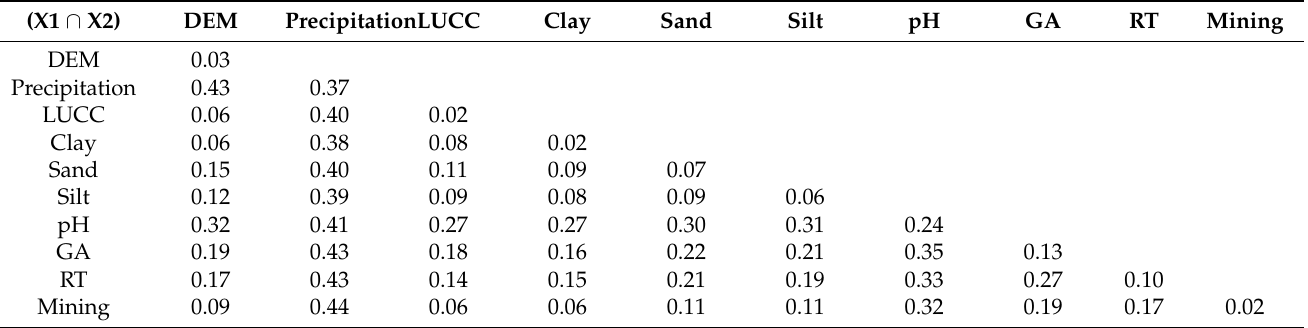
Table 6. Effects of the interaction between each pair of driving factors on the enrichment of the Cd concentration in the